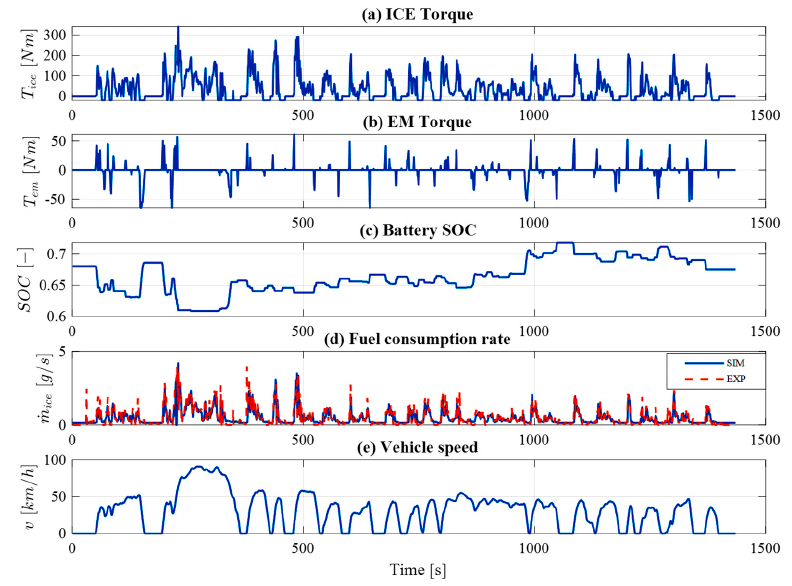
Figure 19. Simulation results with the penalty on the temperature and the temperature change rate on UDDS driving cycle: ( a ) ICE torque, ( b ) EM torque, ( c ) Battery SOC, ( d ) Fuel consumption rate and ( e ) Vehicle speed.